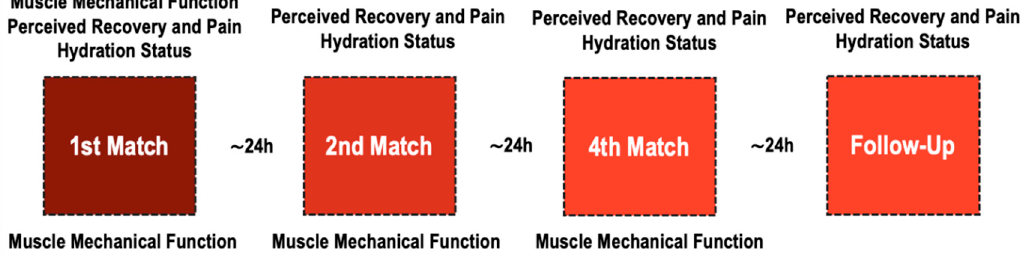
Figure 1. Chronological assessment of variables throughout a multi-sport championship.